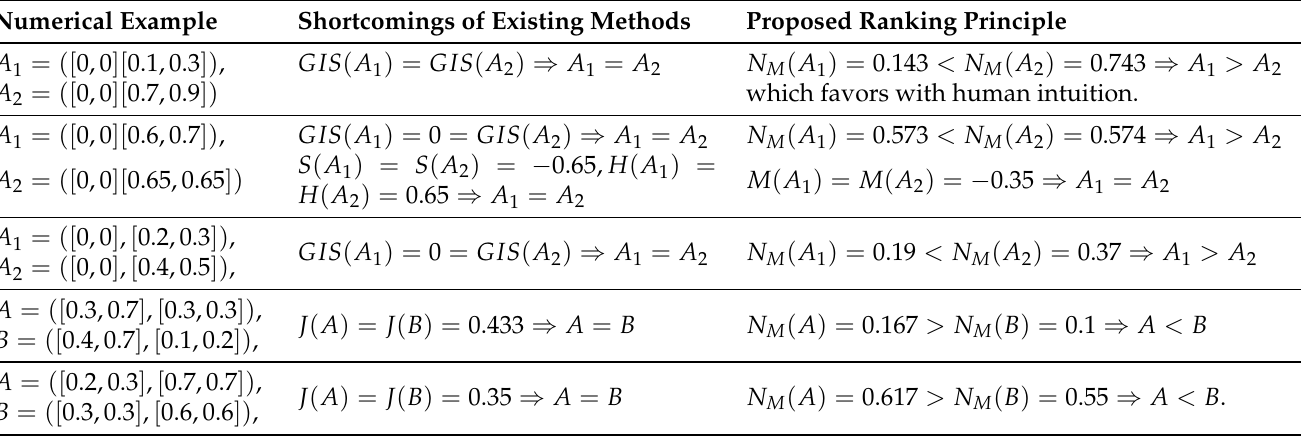
Table 2. Comparison of some existing score function with the proposed non-membership based score function. Numerical Example Shortcomings of Existing Methods Proposed Ranking